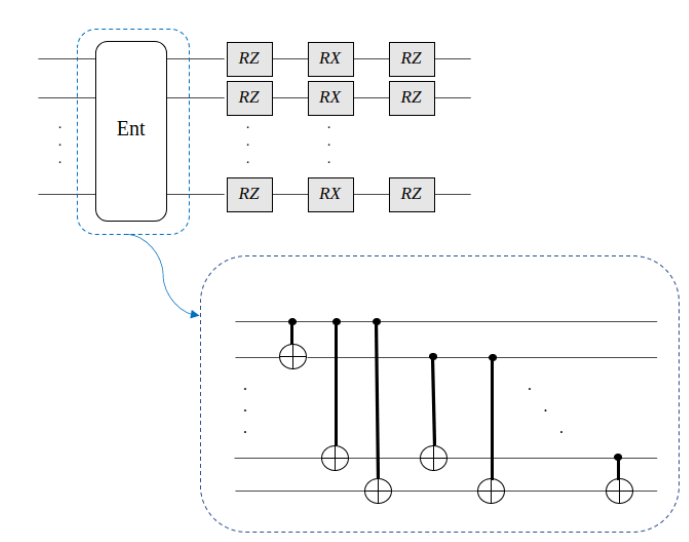
Figure 3. Element layer of an HE circuit